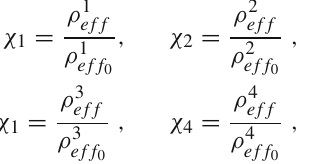
radiation-torsion system in the following figure for OCG Fig. 1.